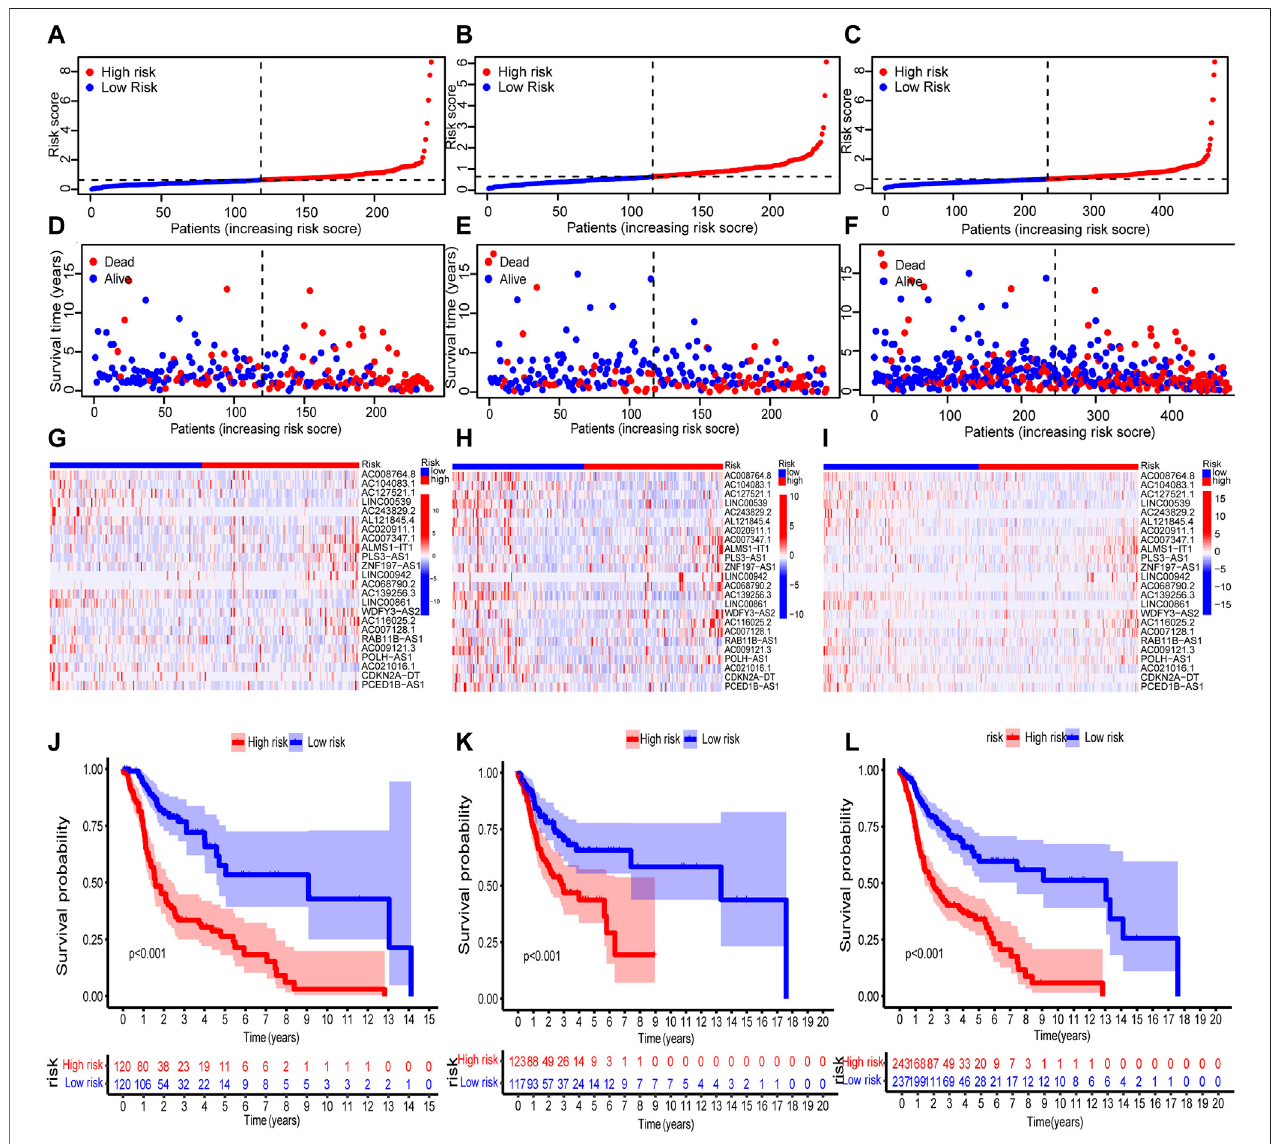
FIGURE4| Theprognosisanalysisofthethree sets(trainingset:A,D, G, J;testset: B,E,H, K;entireset:C,F, I, L). (A – C) Riskscoresofthe high-riskand low-risk groups in the respective three sets. (D – F) Comparison of survival between the two groups in the respective three sets. (G – I) The heat maps of 24 lncRNAs. (J – L) Kaplan – Meiersurvivalcurvesofpatients inthetwogroupsintherespectivethree sets. (M) Kaplan – MeiersurvivalcurvesofOSstrati fi edbyclinicopathologicparameters between the two groups.